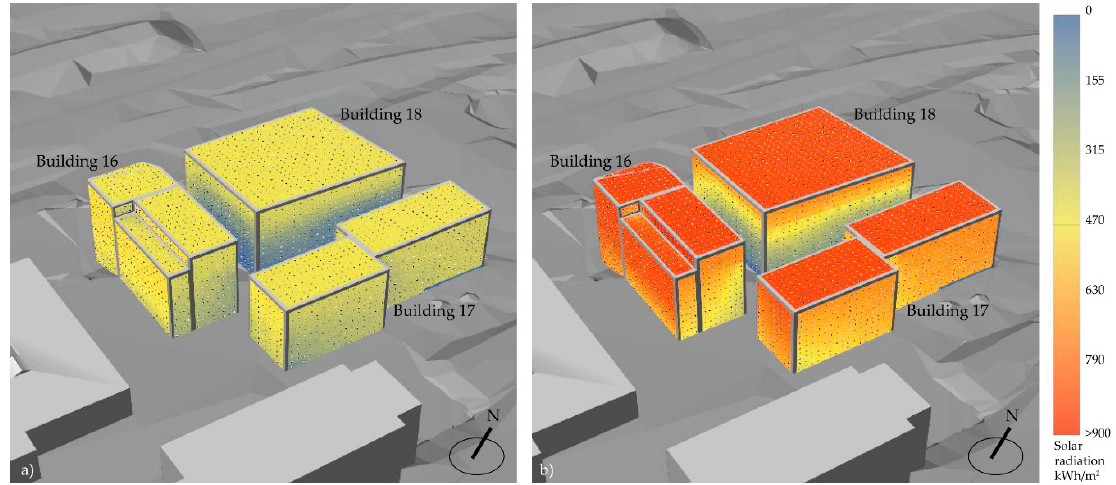
Figure 16. Annual analysis of direct solar irradiation ( a ) and global irradiation analysis ( b ) in the critical area in the existing situation.